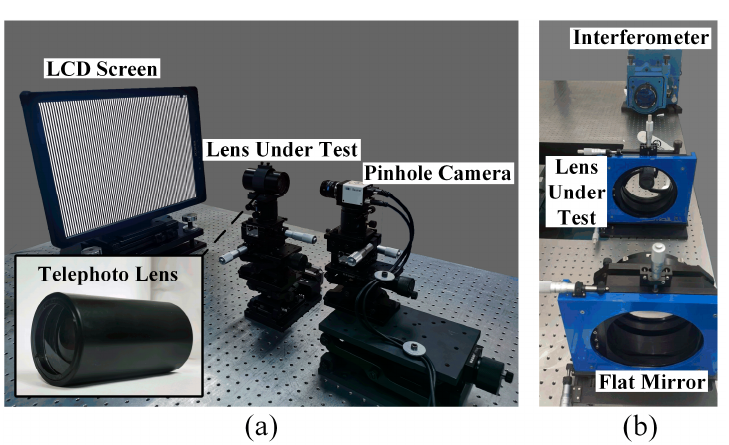
Figure 6. ( a ) WAMD system in the experiment; ( b ) interferometry test system in the experiment.